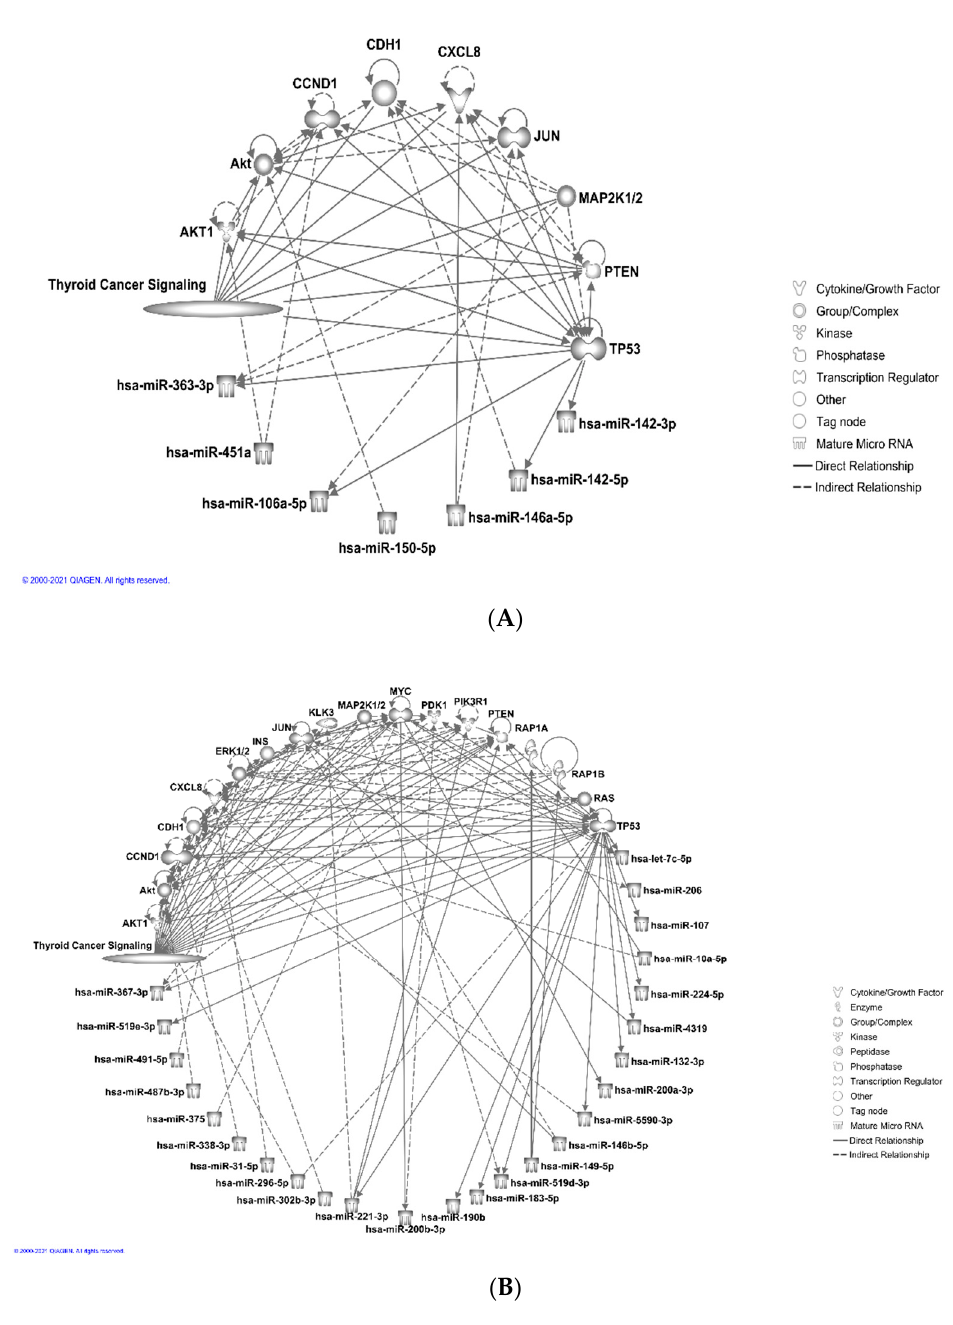
Figure 3. Ingenuity pathway analysis, IPA (© 2021-2021 QIAGEN) for visualization of direct and indirect relationship between miRNAs and their target genes within the thyroid signaling pathway. ( A ) Seven upregulated miRNAs are connected directly or indirectly to ten different molecules within the thyroid cancer signaling pathway. ( B ) Twenty five downregulated miRNAs are connected directly or indirectly to eighteen molecules within the thyroid cancer signaling pathway.